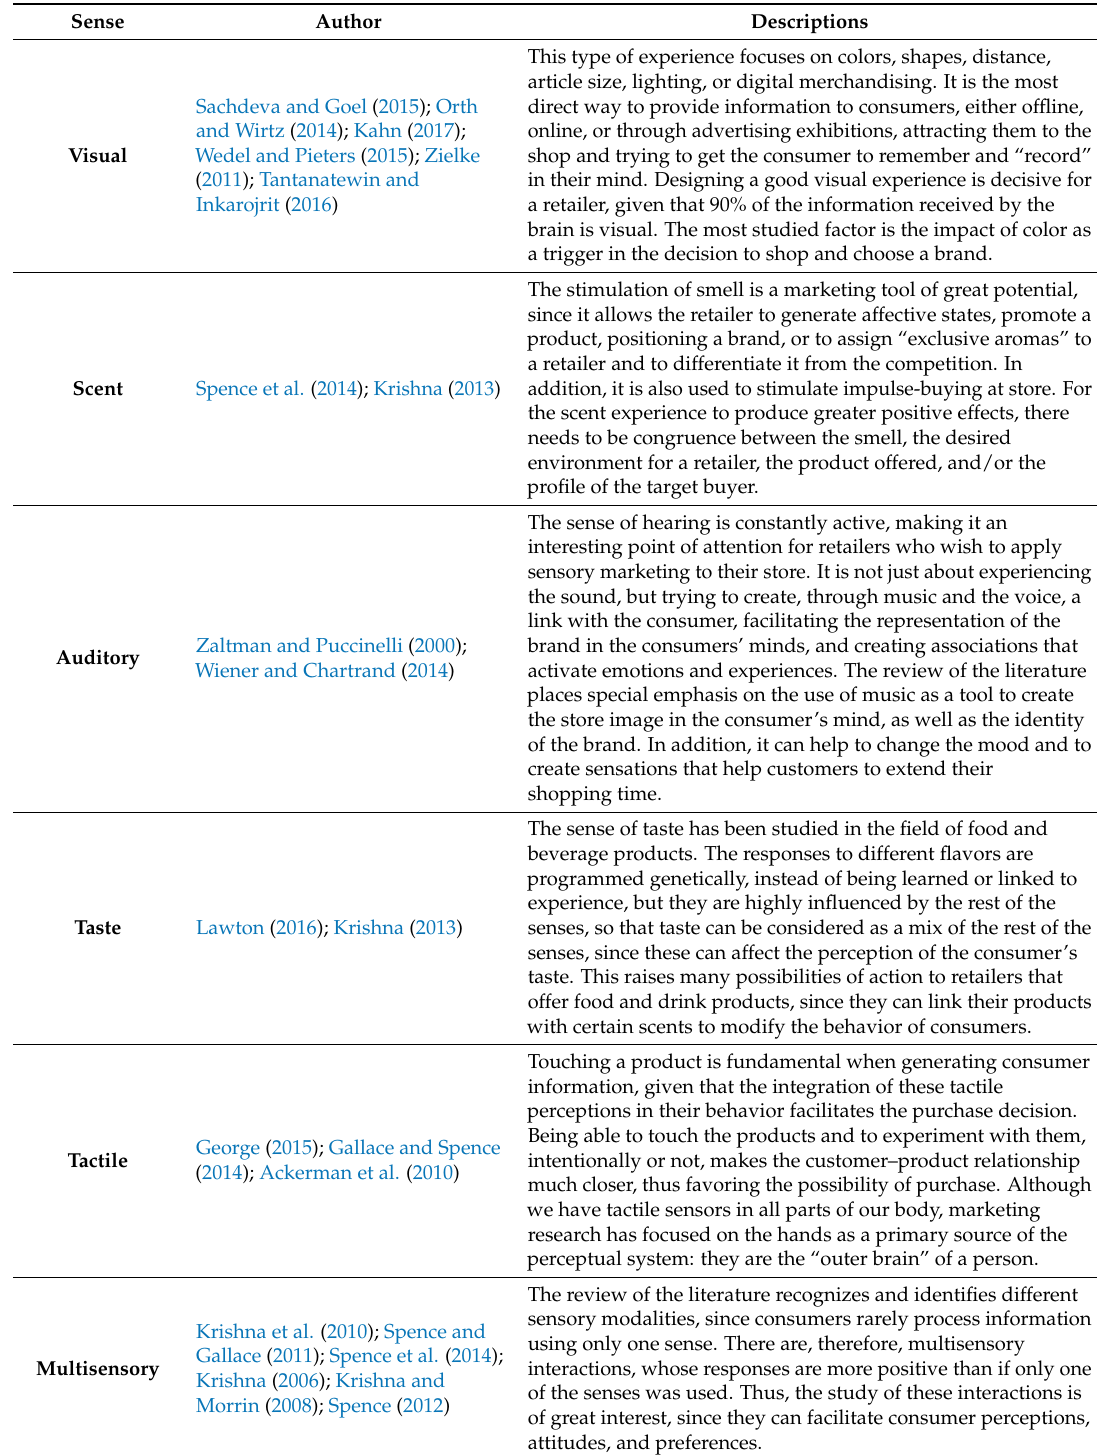
Table 1. Relevant studies related to sensory